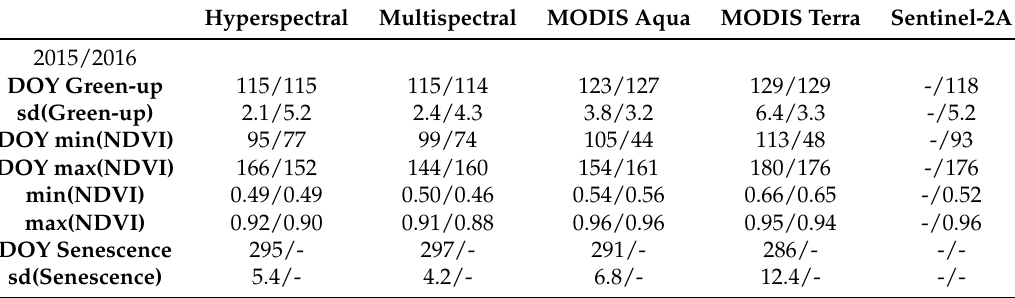
Table 3. Phenological metrics extracted from the NDVI time series with the R-package ‘phenex’. These metrics include the Day Of the Year (DOY) of green-up, senescence and respective standard deviations (sd), minimum and maximum NDVI, as well as the DOY of their occurrences. A dash (-) indicates if the metric could not be extracted from the specific time series due to unavailable